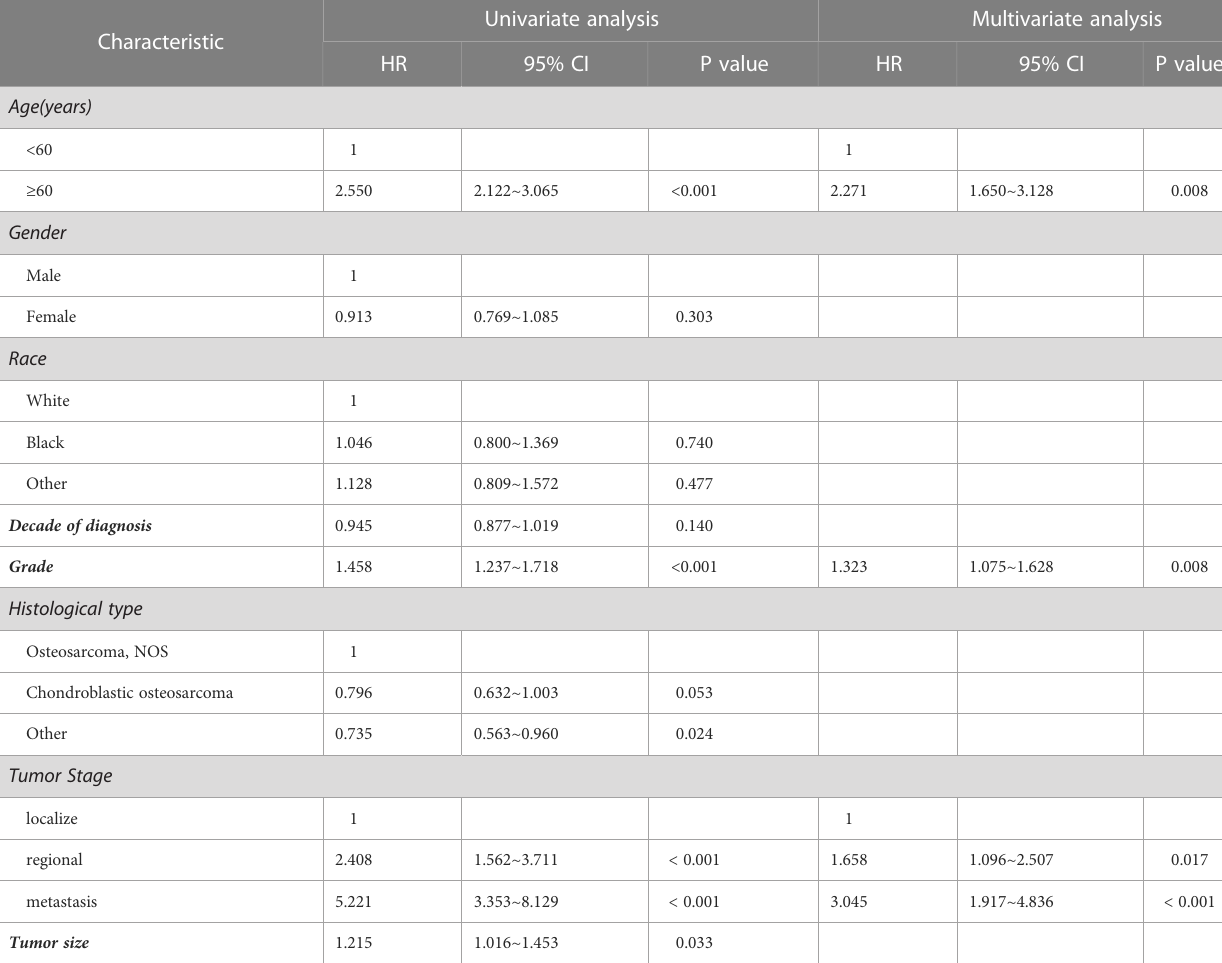
TABLE 2 Univariate and multivariate analysis for clinical factors associated with OS of spinal osteosarcoma patients.